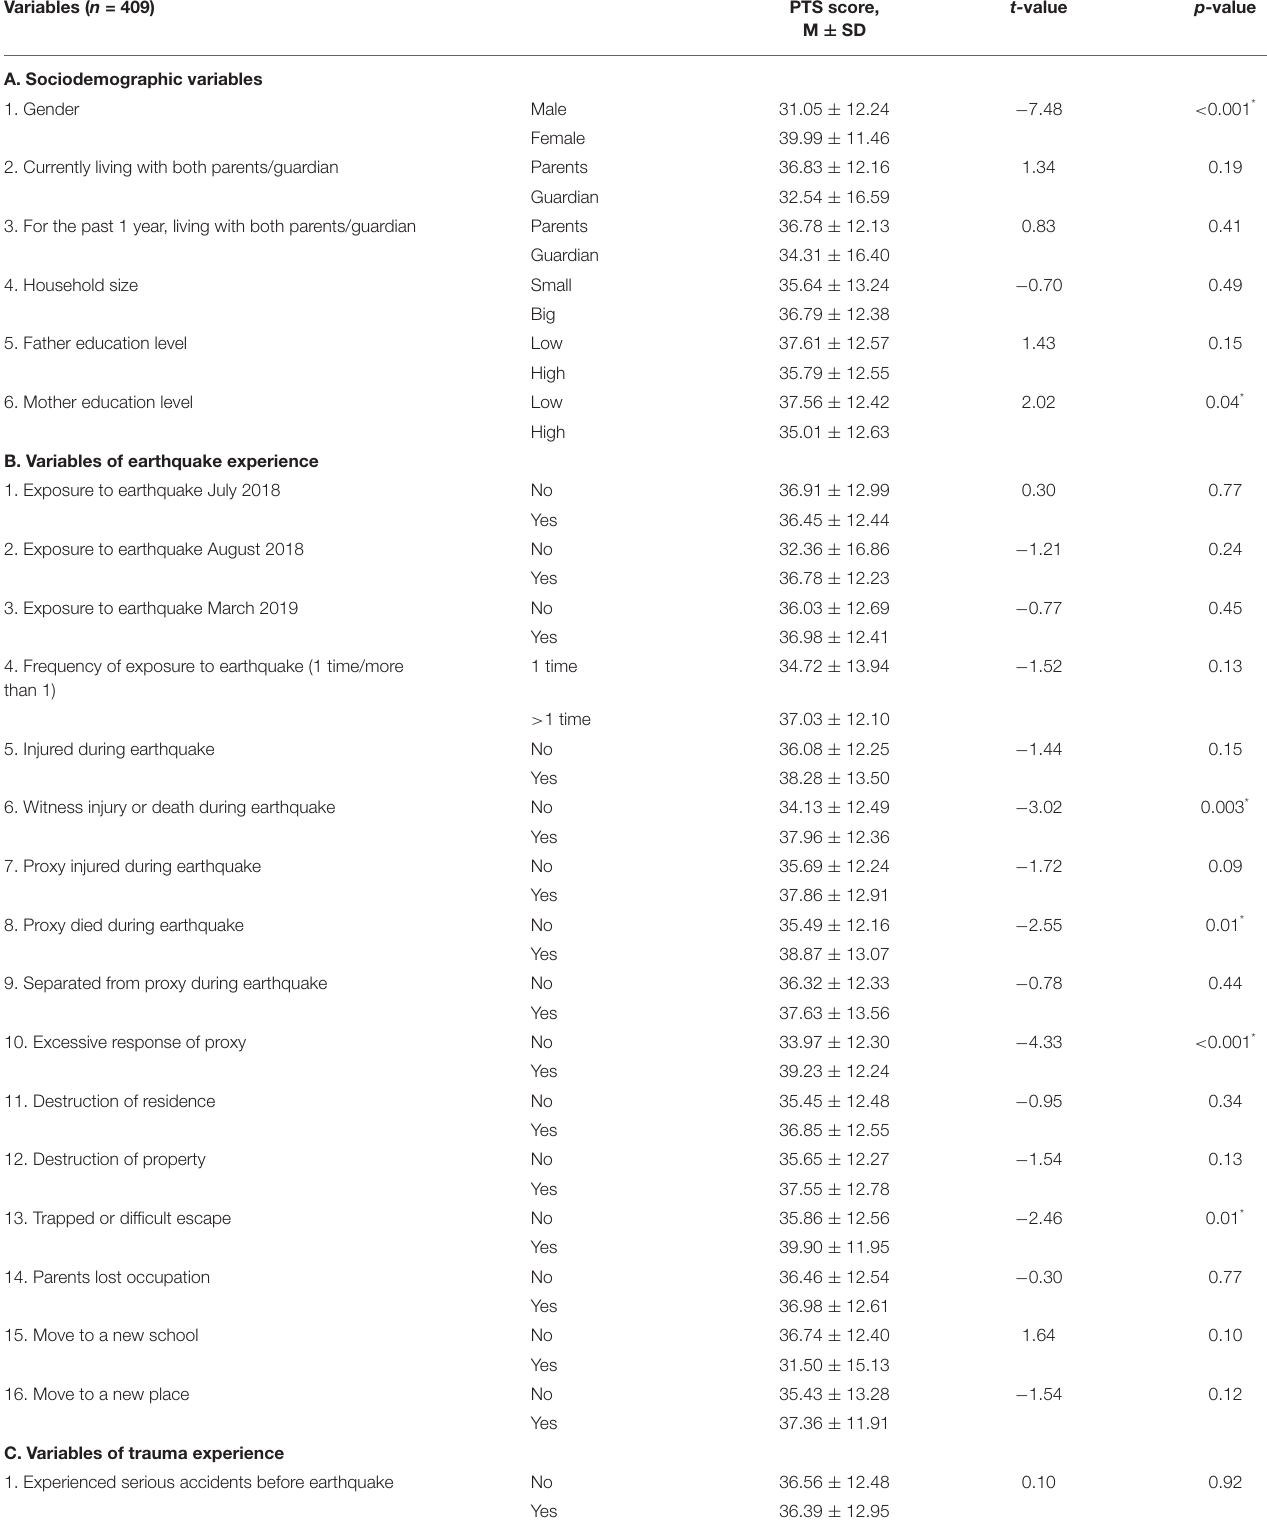
TABLE 2 | Mean PTS score differences between groups. Variables ( n =